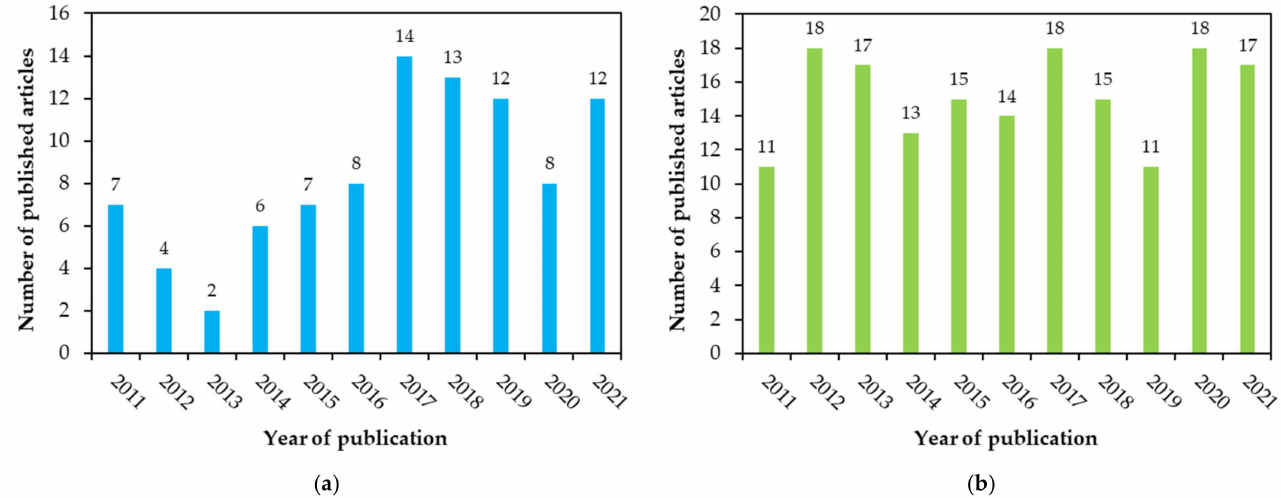
Figure 1. Number of published articles in international journals included in PubMed database: a summary of 10 years of publishing for ( a ) HMs biosorption by microorganisms and ( b ) POPs biodegradation by